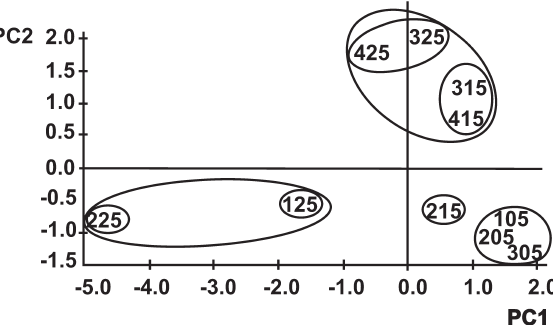
Fig . 2. – Results of the PCA (abiotic parameters included - sedi- ment: Size Q50, organic material, clay, gravel and bioclasts, and depths). The numbers are the sampling stations (examples: 105: ra- dial 1 at 05 m depth, 425: radial 4 at 25 m